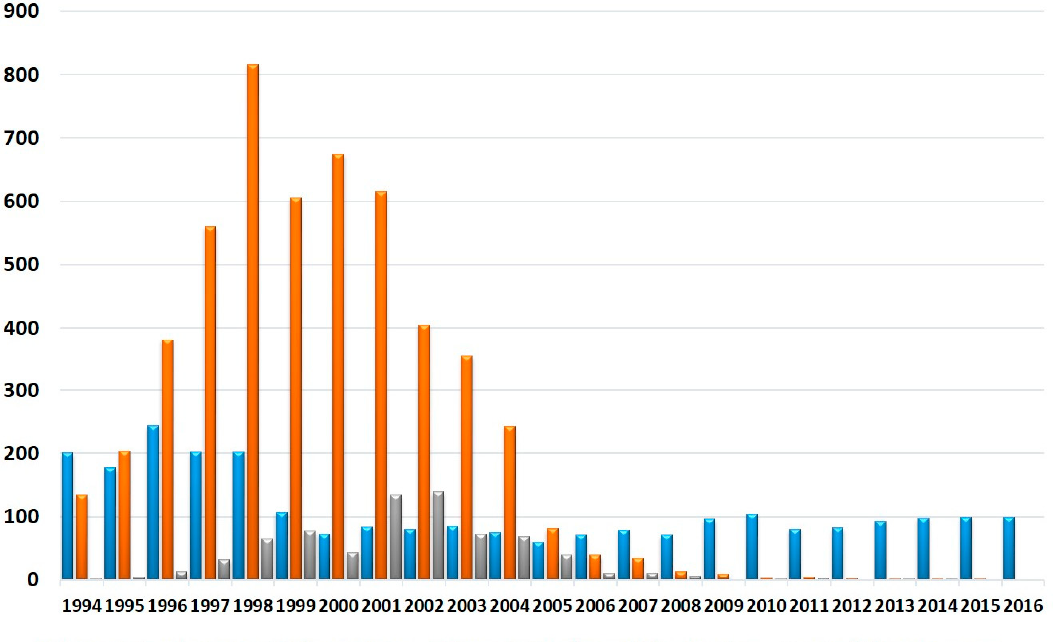
Figure 1. Malaria cases in Russia. Source: Russian Federal Service for Surveillance on Consumer Rights Protection and Human Wellbeing (Rospotrebnadzor). * CIS—Commonwealth of Independent States, consisting of a part of former Soviet Republics.